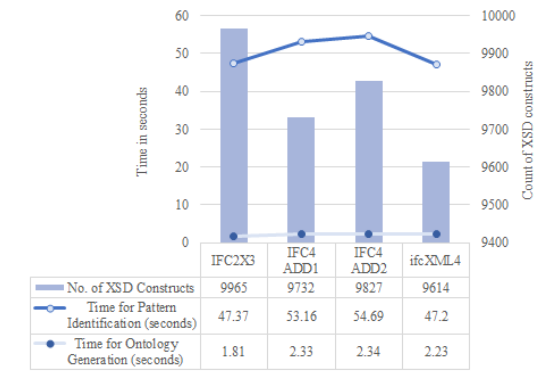
Figure 6. Results comparing execution time for pattern identification and ontology generation of IFC schemas for listed transformation patterns in Table